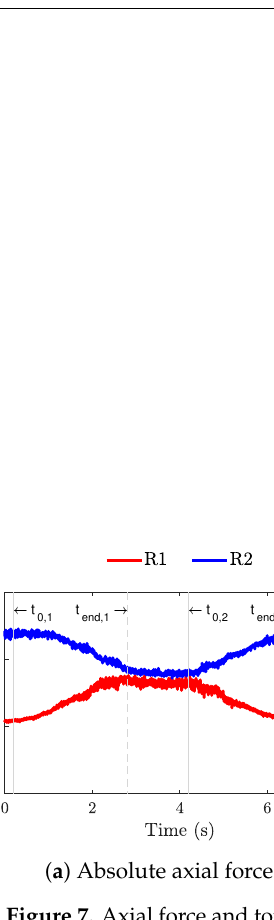
Figure 7. Axial force and torque on the runners and transverse forces for Runner 1, as a function of time during the transient sequence in turbine mode. The z -component is the axial